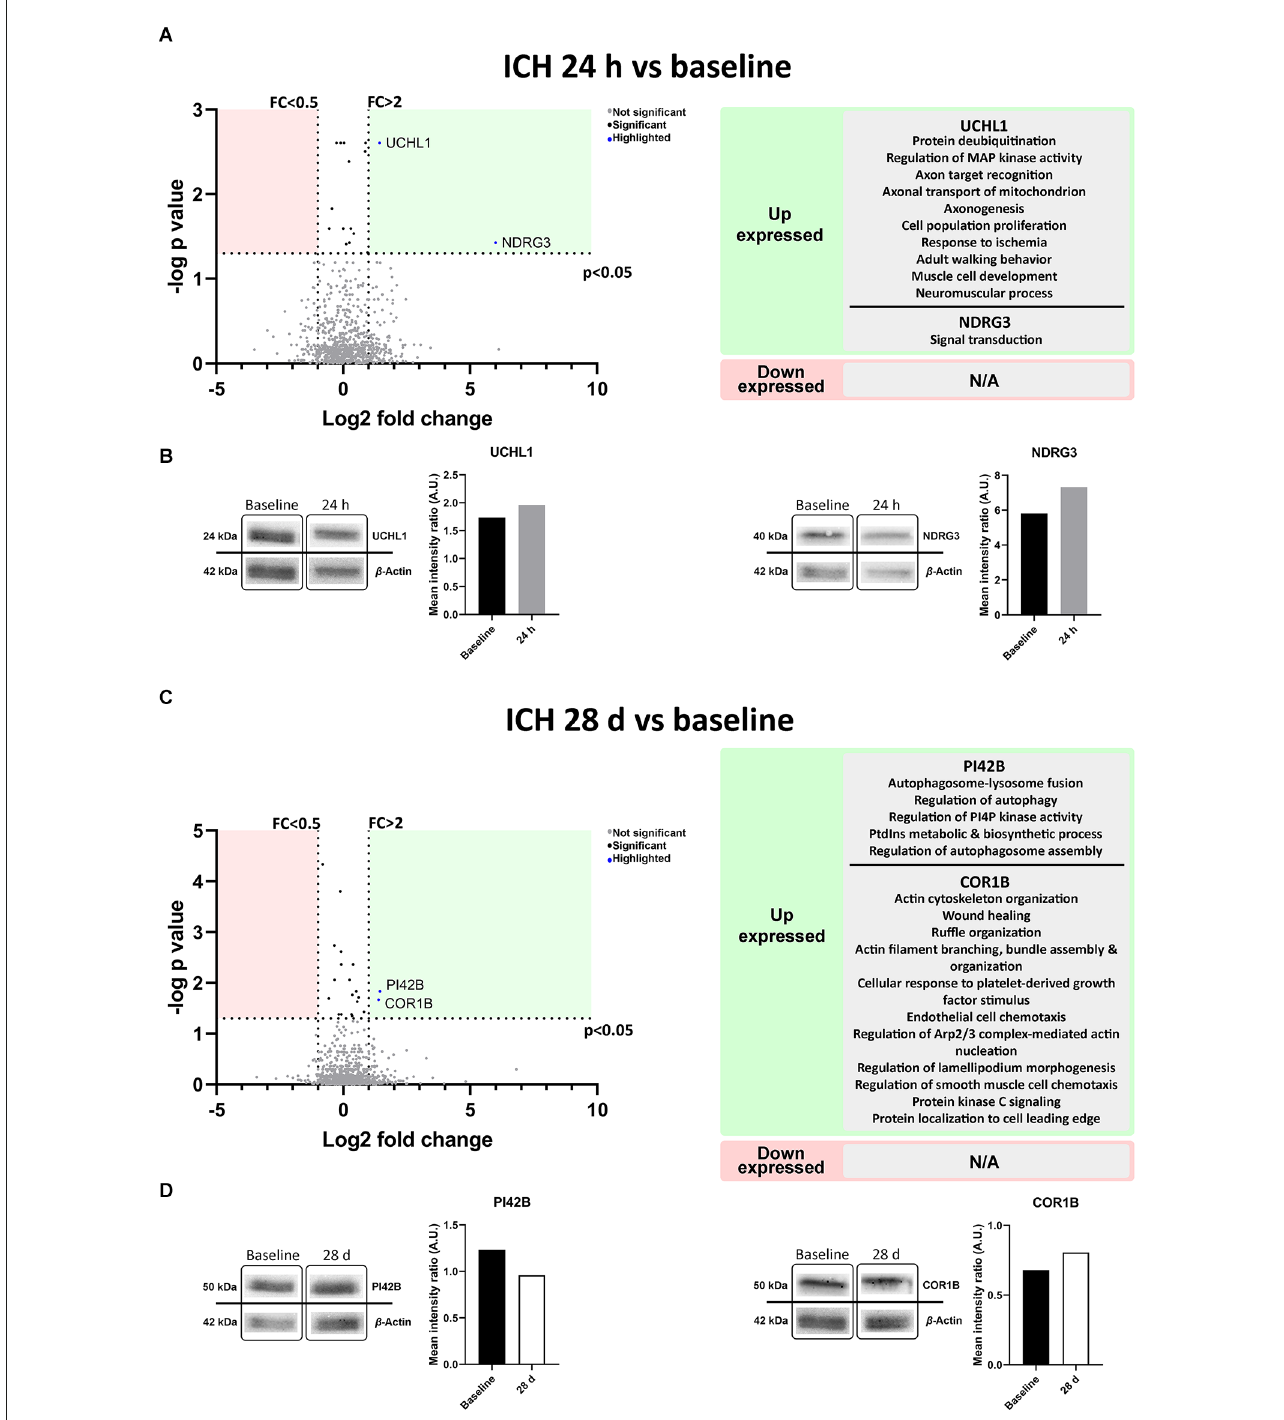
FIGURE5 Protein content in blood-derived EVs, outlining their biological processes. (A,C) The volcano plots represent proteins present in the EVs compared by time point. Biological processes in which the differential proteins as described by UniProt appear to be involved are shown on the right. (B,D) Immunoblot assays of the selected proteins from the proteomic study. Protein detection cropped image and graphs from band quantification are shown. Abbreviations: AU, arbitrary units; EVs, extracellular vesicles; FC, fold change; ICH, intracerebral hemorrhage.